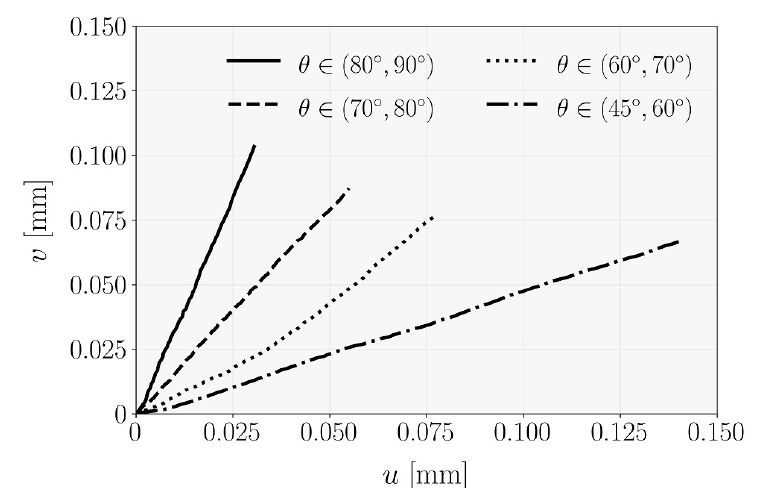
Figure 4. Pattern of the local deformation for each mixed mode ratio of the MMB tests.